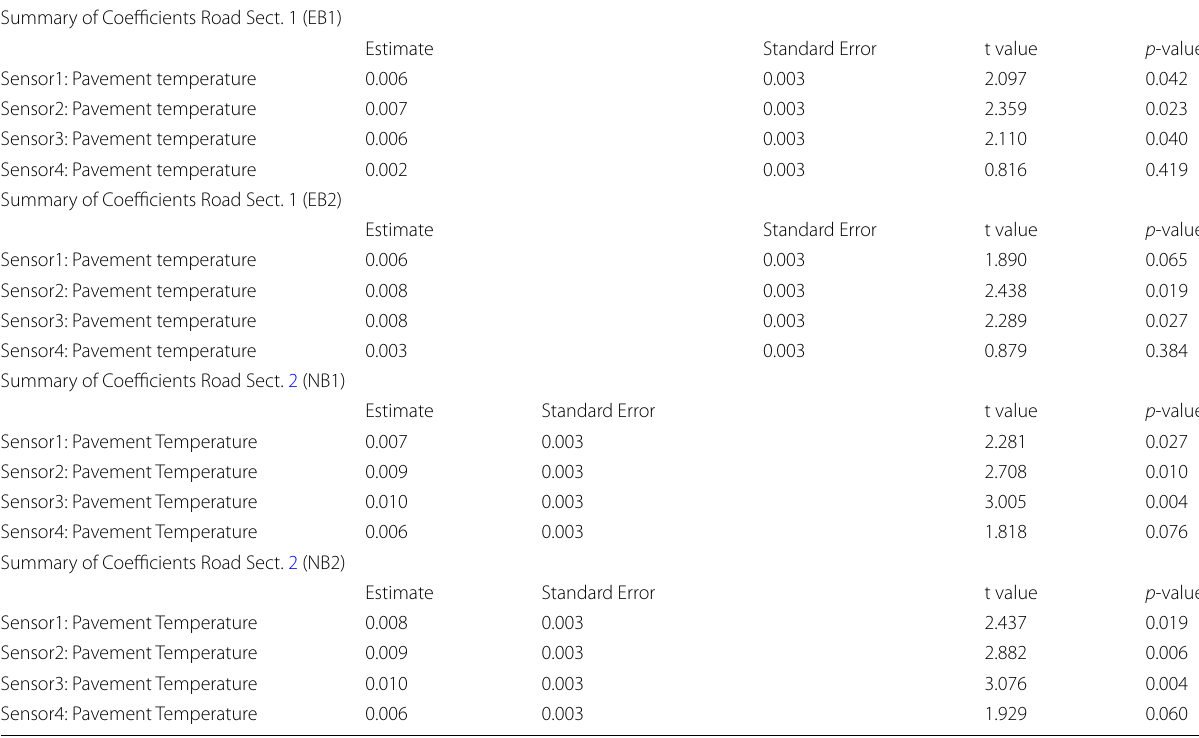
Table 6 Coefficients of interaction terms from ANCOVA test of two road sections Summary of Coefficients Road Sect. 1 (EB1)